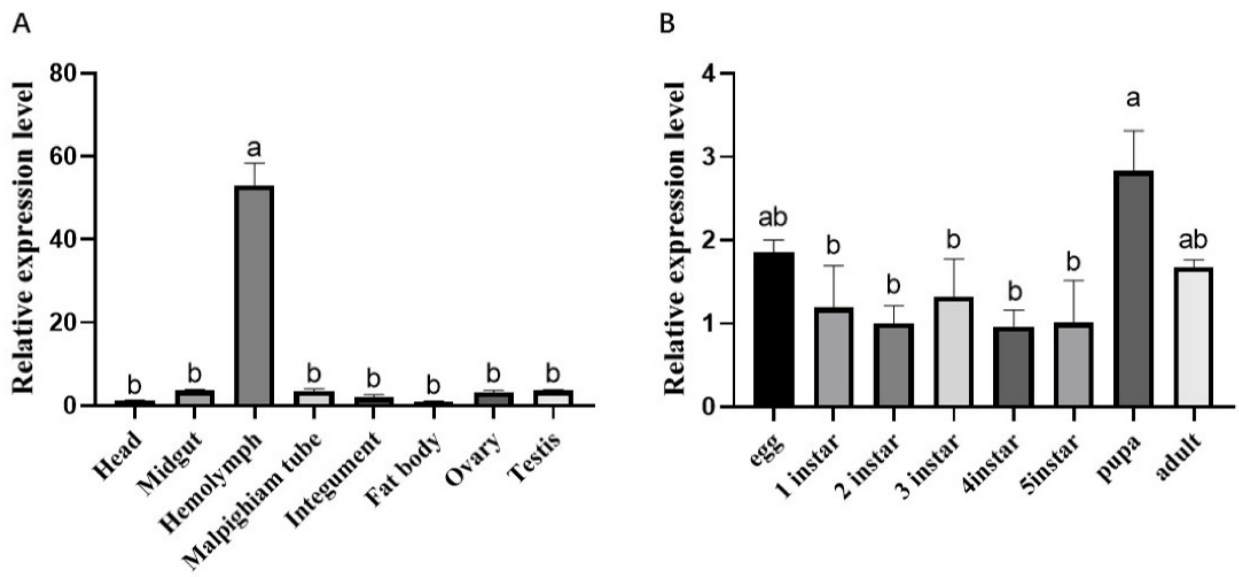
Figure 6. Expression analysis of BmTex261 in different tissues and developmental stages using RT-qPCR. ( A ) Relative expression levels of BmTex261 among different tissues; ( B ) relative expression levels of BmTex261 among different stages. BmGAPDH was used to normalise the data that are shown as the mean ± standard error; the mean was obtained from three independent repeats. The 2 − ∆∆ Ct method was adopted to calculate the relative expression level. The statistical difference among three biological duplicates, determined with one-way ANOVA, is shown via graphpad prism. Different letters indicate statistically significant differences (a, b; p <